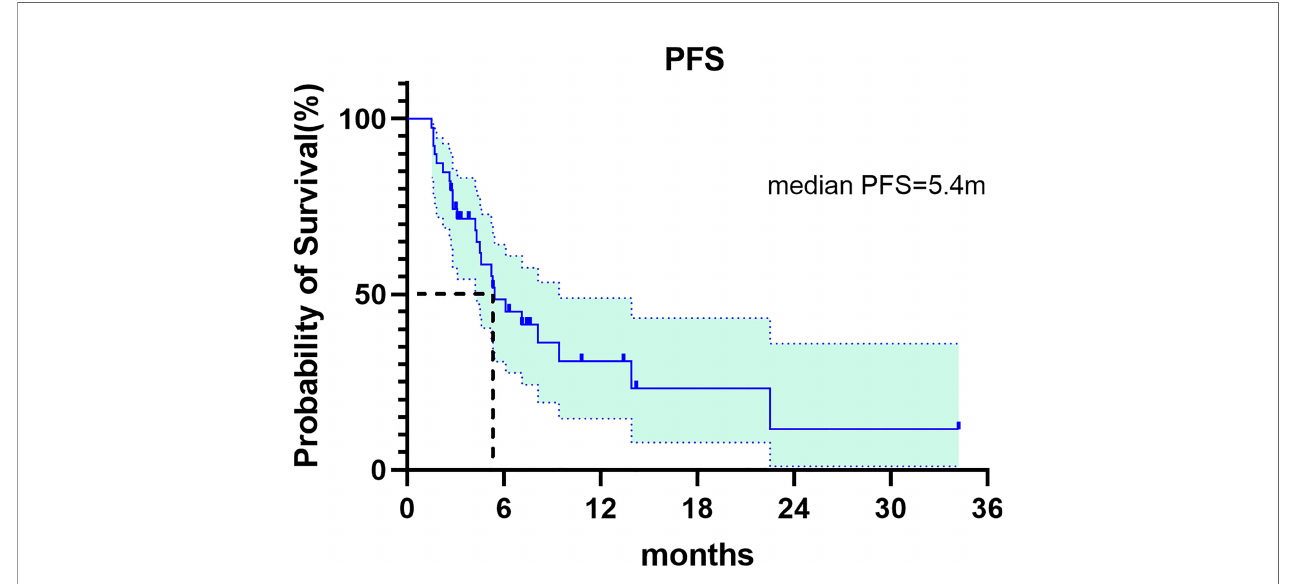
FIGURE 1 | Kaplan-Meier curve of PFS for the overall study